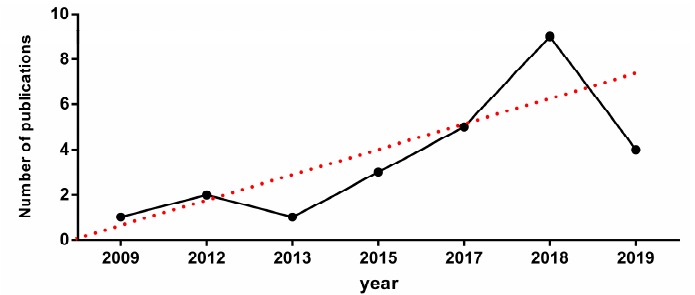
Figure 4. Publications in the last few years.